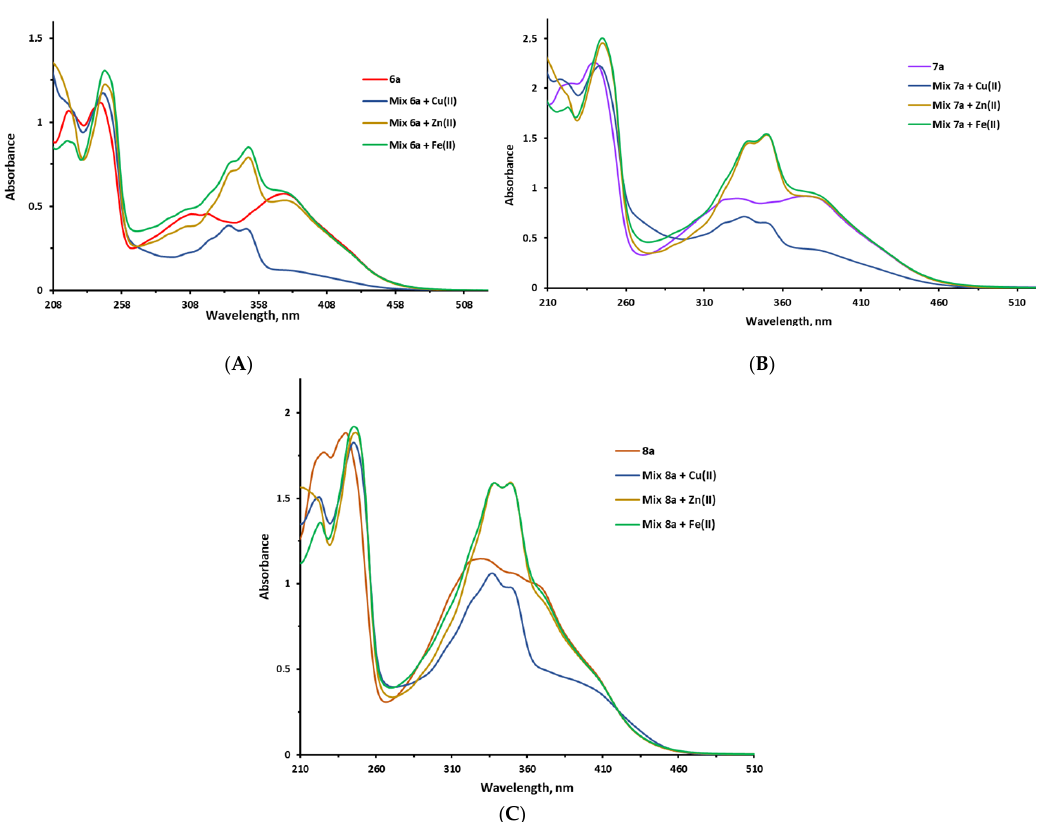
Figure 6. Absorption spectra of compounds 6a ( A ), 7a ( B ) and 8a ( C ) in a concentration of 40 µM and their mixture with Cu 2+ , Zn 2+ , Fe 2+ ions solution (40 µM) in acetonitrile solution at 25 °C.